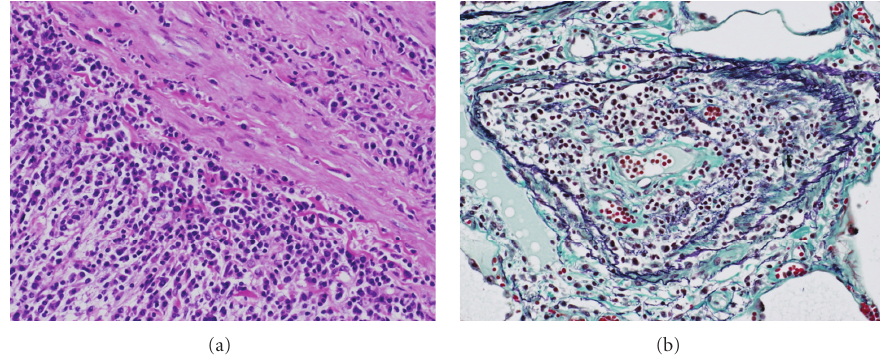
Figure 7: Microscopic findings of the pulmonary vasculature a ff ected by plasma cell myeloma. (a) The pulmonary artery showing marked plasma cell proliferation. The adventitia is predominantly a ff ected (hematoxylin-eosin, original magnification × 200). (b) A cross-section of the arteriole indicating plasma cell proliferation. The vascular wall is thickened and the lumen becomes narrow (elastica Masson, original magnification ×